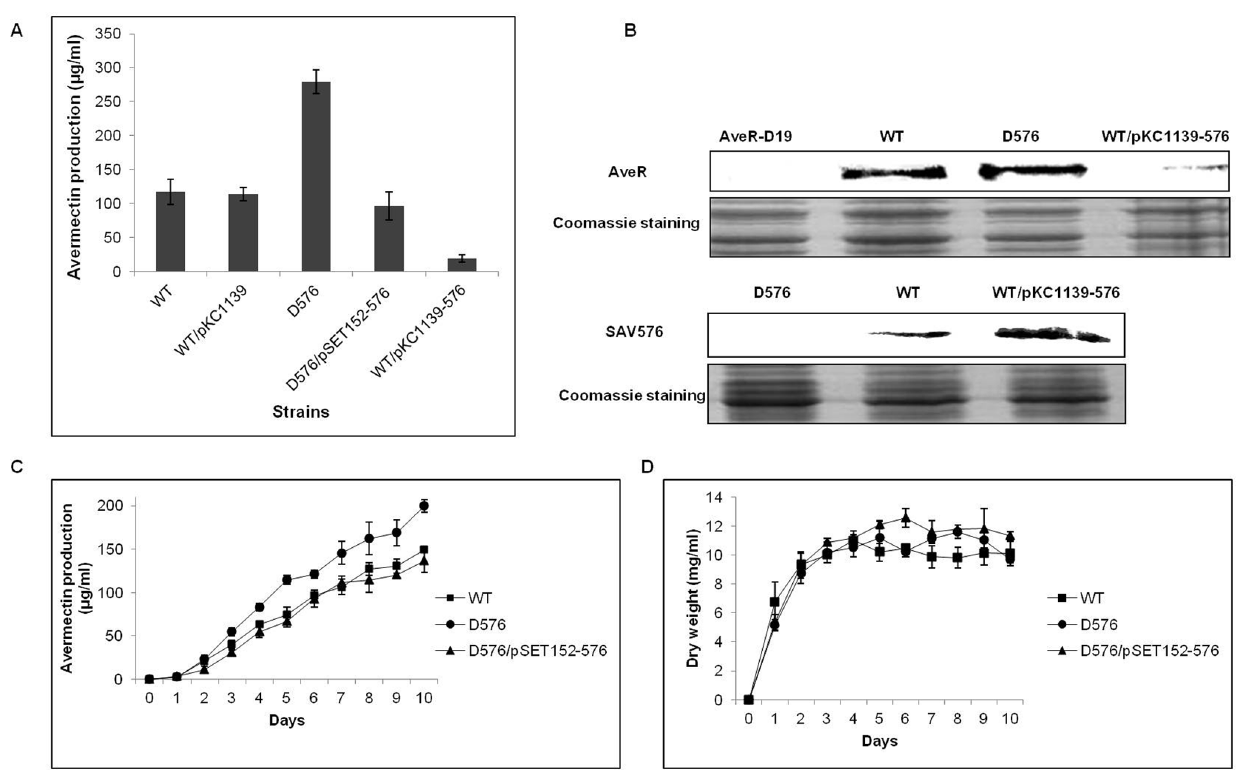
Figure 2. Avermectin production and growth of wild-type ATCC31267 and SAV576 mutant strains. ( A ) Comparison of avermectin production in various S. avermitilis strains grown in FM-I medium for 10 days. WT, wild-type strain ATCC31267; WT/pKC1139, ATCC31267 carrying control plasmid pKC1139; D576, SAV576 deletion mutant; D576/pSET152-576, complementation strain of D576; WT/pKC1139-576, SAV576 overexpression strain. ( B ) Western blotting analysis of SAV576 and AveR protein in cells grown in FM-I for 6 days. Approximately 100 m g total protein of each sample was subjected to Western blot and Coomassie Blue staining for the loading control. AveR-D19, aveR mutant. ( C and D ) Effect of SAV576 deletion on avermectin production ( C ) and growth ( D ) of S. avermitilis grown in FM-II. Solid squares, ATCC31267; Solid circles, D576; Solid triangles, complementation strain of D576.